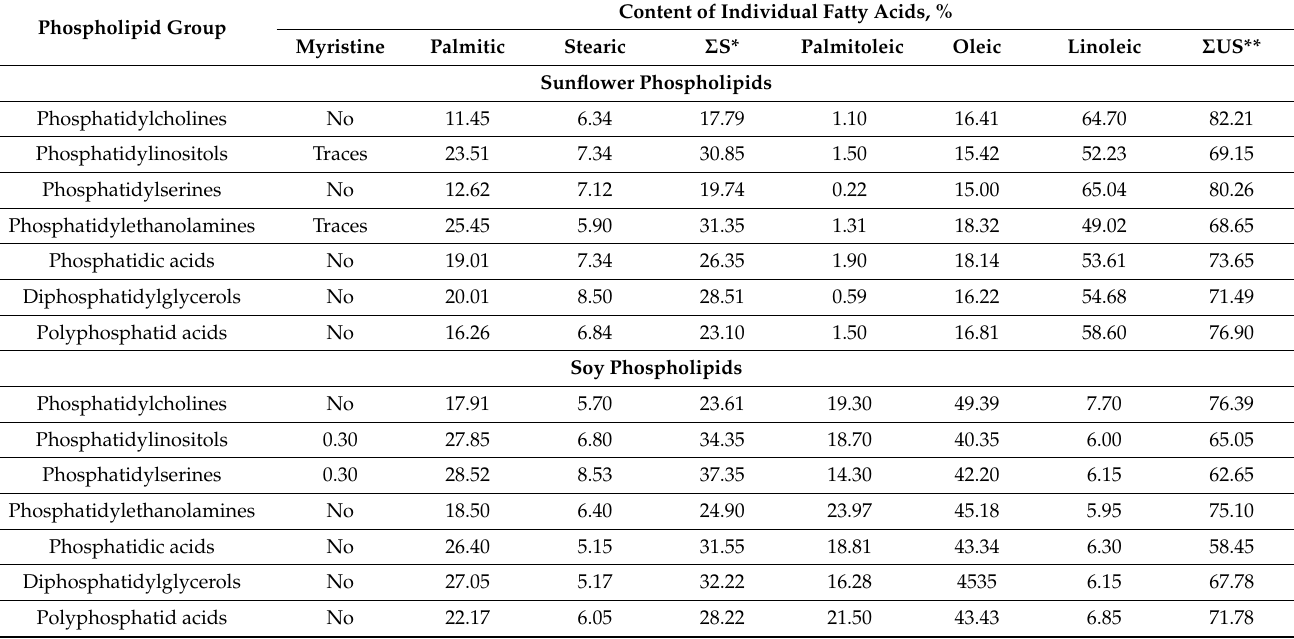
Table 6. Fatty acid composition of the phospholipid